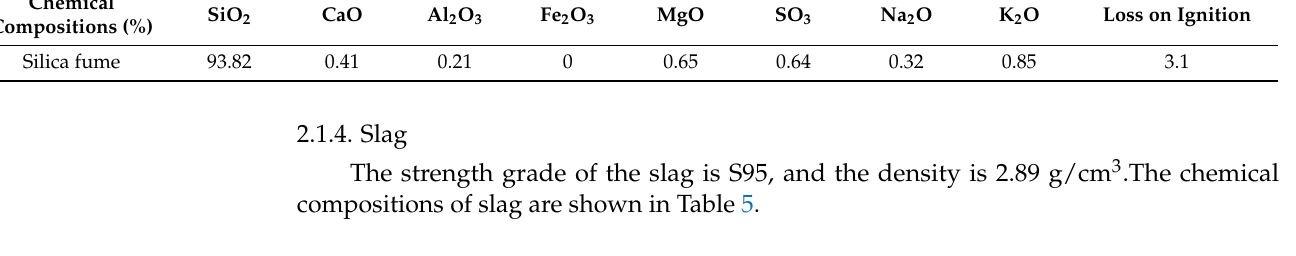
Table 5. Chemical compositions of slag.